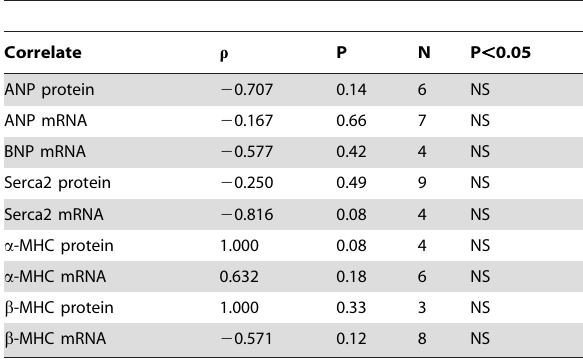
Table 7. Spearman correlations of fetal genes with absolute heart weight in rodent models of type 1 diabetes.